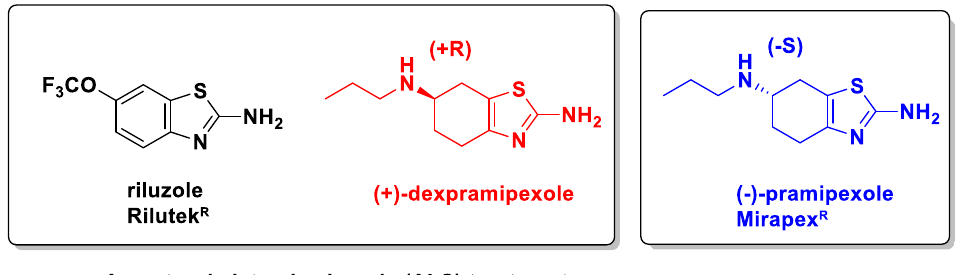
Figure 10. Chemical structures of riluzole, dexpramipexole, and (−)-pramipexole.